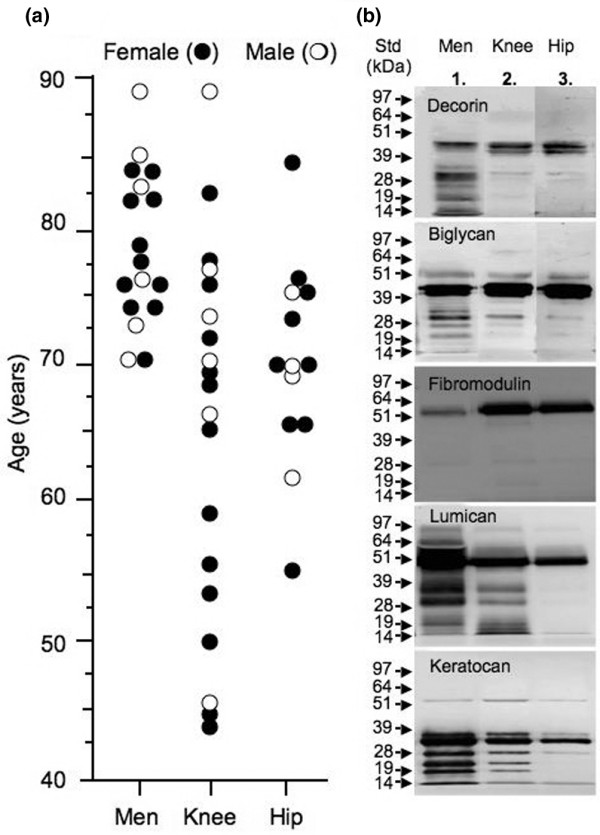
Assessment of SLRP fragmentation. Presented is an assessment of small leucine-rich proteoglycan (SLRP) fragmentation in human meniscus (Men), knee and hip articular cartilage extracts by Western blotting. (a) The age and sex distribution of the total knee and hip replacement tissue donors used in this study. (b) Pooled tissue extracts were examined by Western blotting. Pooled 4 M GuHCl tissue extracts were fractionated by centrifugal diafiltration and the 5 to 100 kDa fraction used. All samples were pre-digested with chondroitinase ABC and keratanase-I before electrophoresis. Sample loadings were normalized by loading extracts corresponding to equivalent wet weights of tissue in each lane for comparison.